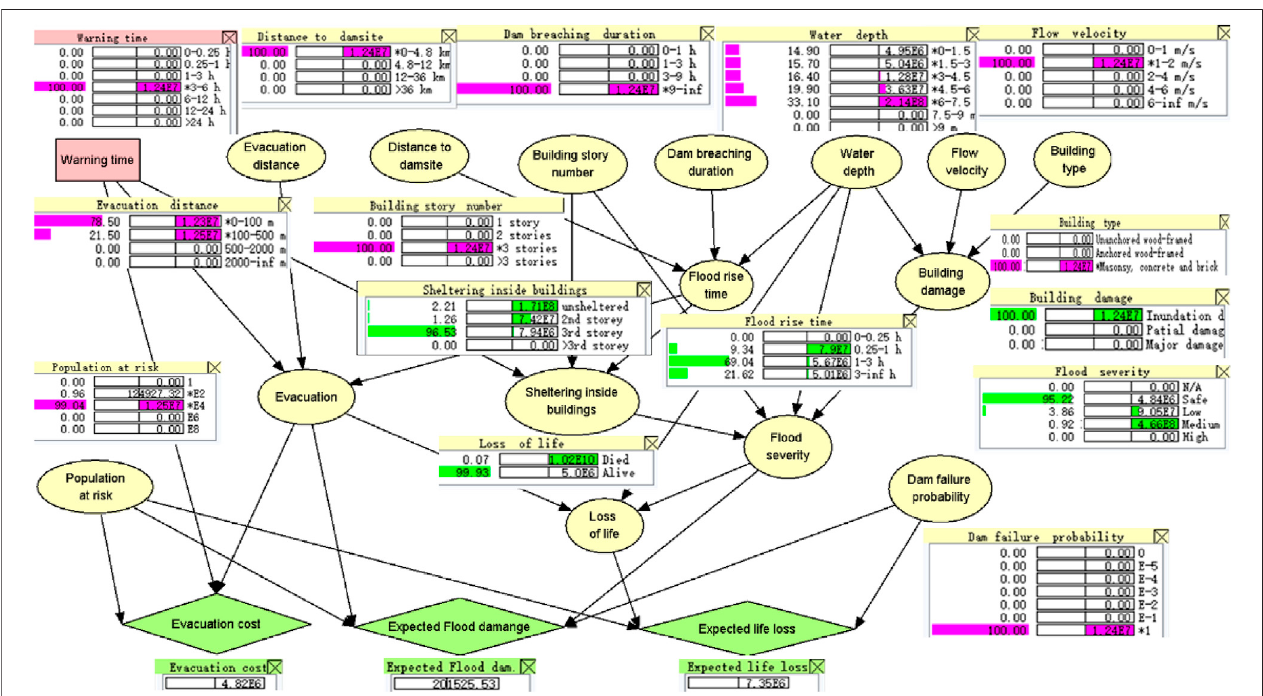
FIGURE 10 | Decision-making based on In fl uence Diagram with Hugin lite 7.2 (Hugin Expert A/S, 2009).